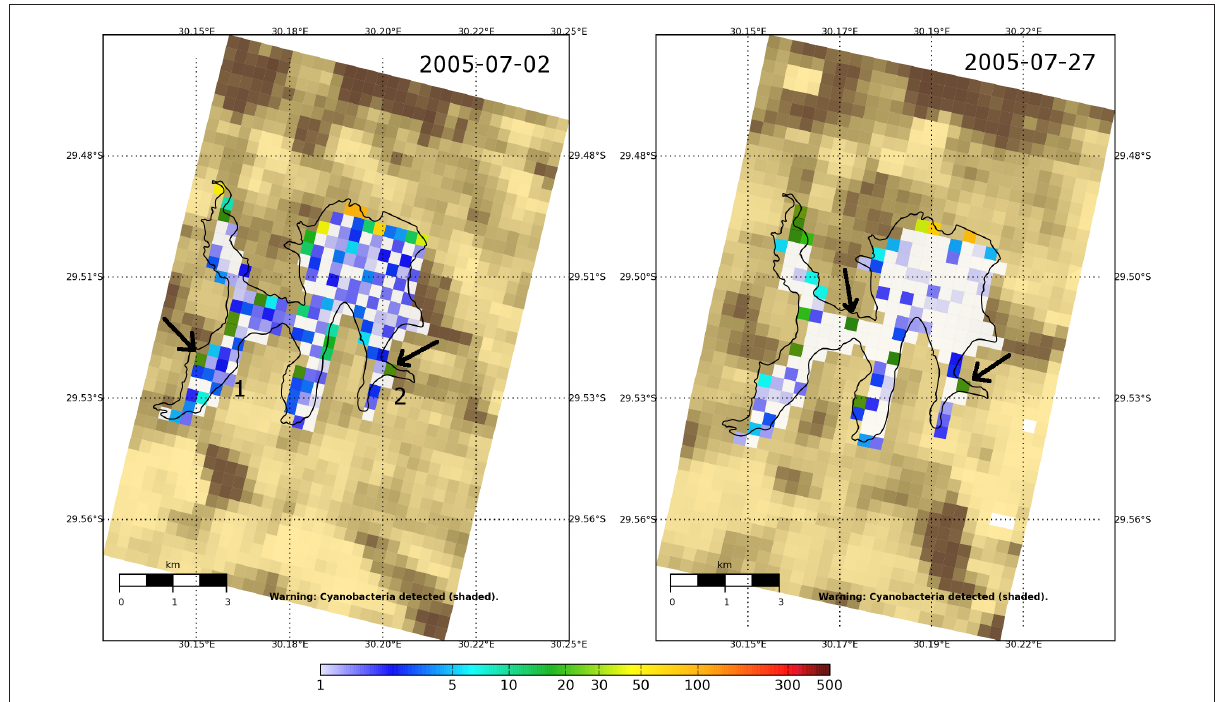
Figure 3: Chl- a maps for Midmar Dam showing two scenes acquired near or simultaneous to measurements made by Oberholster and Botha 24 illustrating winter cyanobacteria detection. The sample points in Oberholster and Botha 24 are indicated at 1 and 2; the maximum chl- a value measured was 92 mg/m 3 . The arrows indicate pixels identified as Landsat satellite imagery to observe these hyperscums and surface scum accumulations. These surface scums were also identified from MERIS 21 . MERIS data acquired 10 min or less apart from Landsat imagery is used to demonstrate the detection of scum (Figure 4). Surface scums appear as bright green slicks on the water surface in the true colour Landsat imagery, 29 and are coloured dark green for pixels in the MERIS scenes. The simultaneously acquired Landsat and MERIS scenes have very similar spatial patterns which verify the accuracy of scum detection from the lower spatial resolution MERIS data.